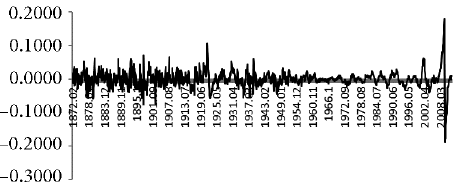
Figure 4. Growth in dividend payout ratio